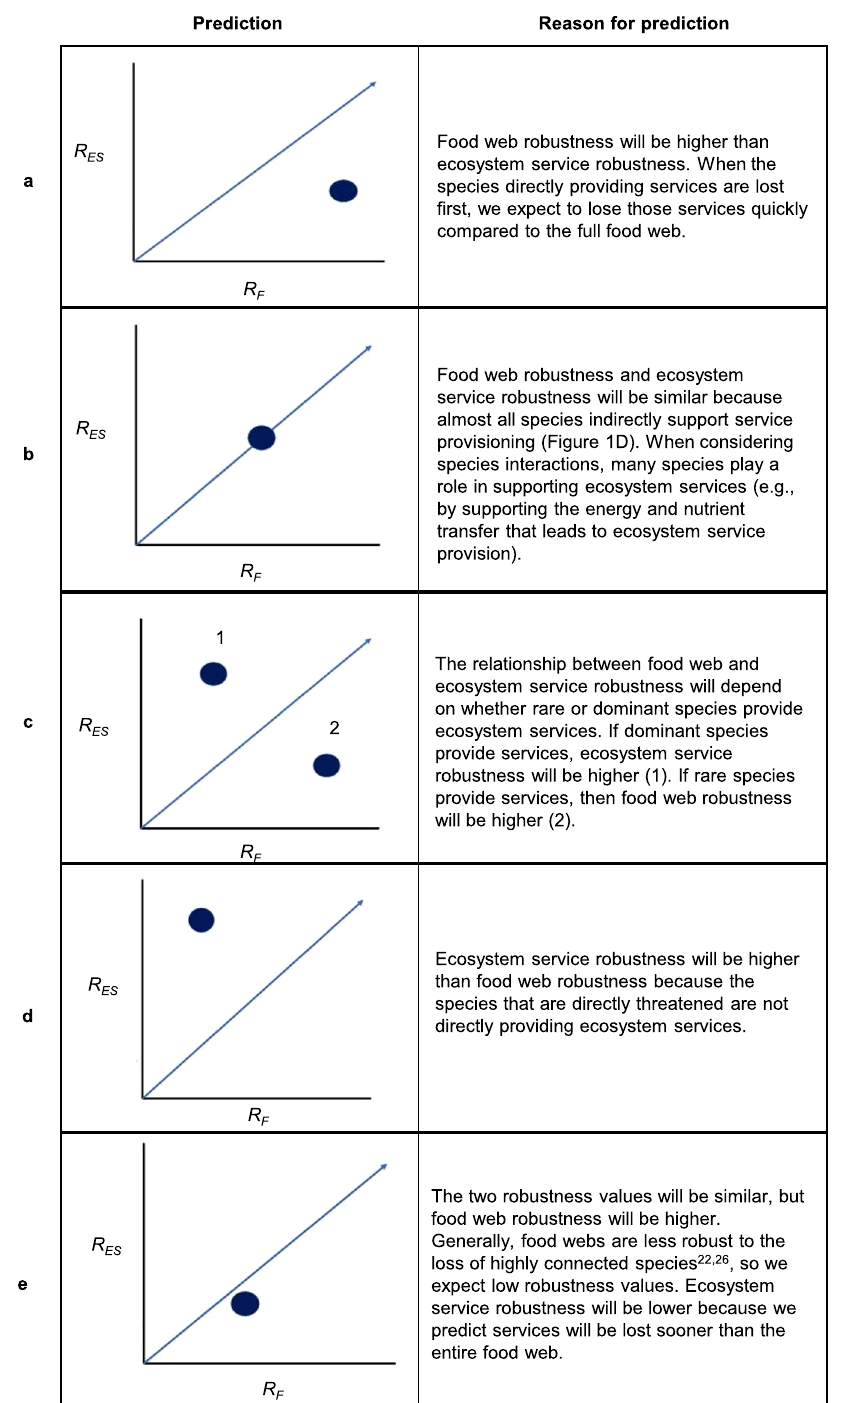
Fig. 2 Predictions for the relationship between food web robustness ( R F ; the tolerance of a food web to species loss) and ecosystem service robustness ( R ES , the tolerance of ecosystem service nodes in a network to species loss). In each fi gure (( a – f ), middle column), the x axis is food web robustness, the y-axis is ecosystem service robustness, and the blue line represents a 1:1 relationship between the two ( x = y ). The dots show the relationship we expect between the two robustness values under each sequence of species loss, shown in different rows: a – e . Thus, if the robustness of the ecosystem services is highly correlated with the robustness of the food webs, the blue dot would fall on the